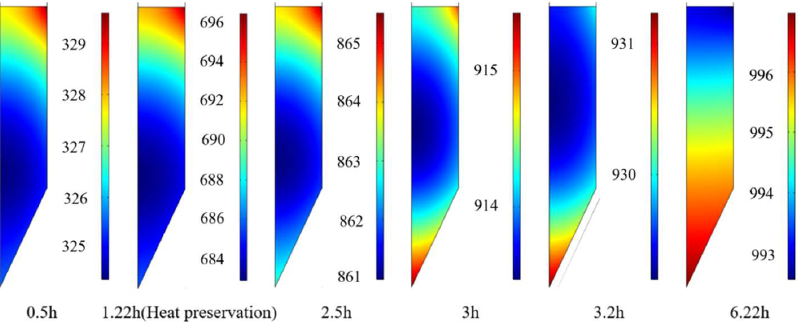
Figure 7. The temperature field of LiH during heating and the heat preservation process (T[K]).